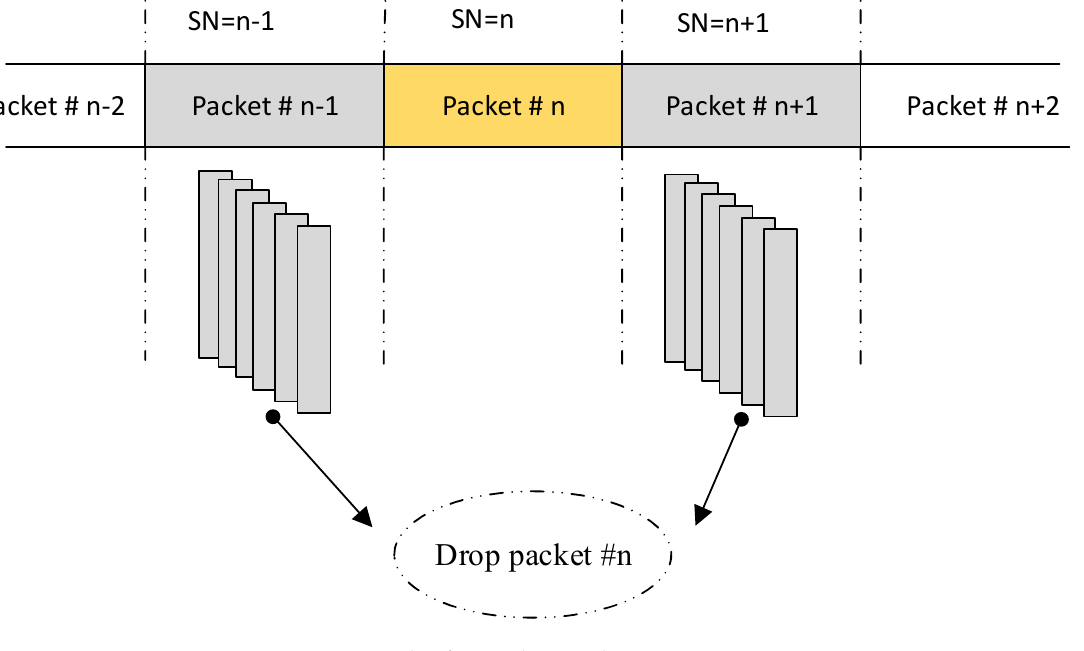
Figure 14. An example of an undersampling case.